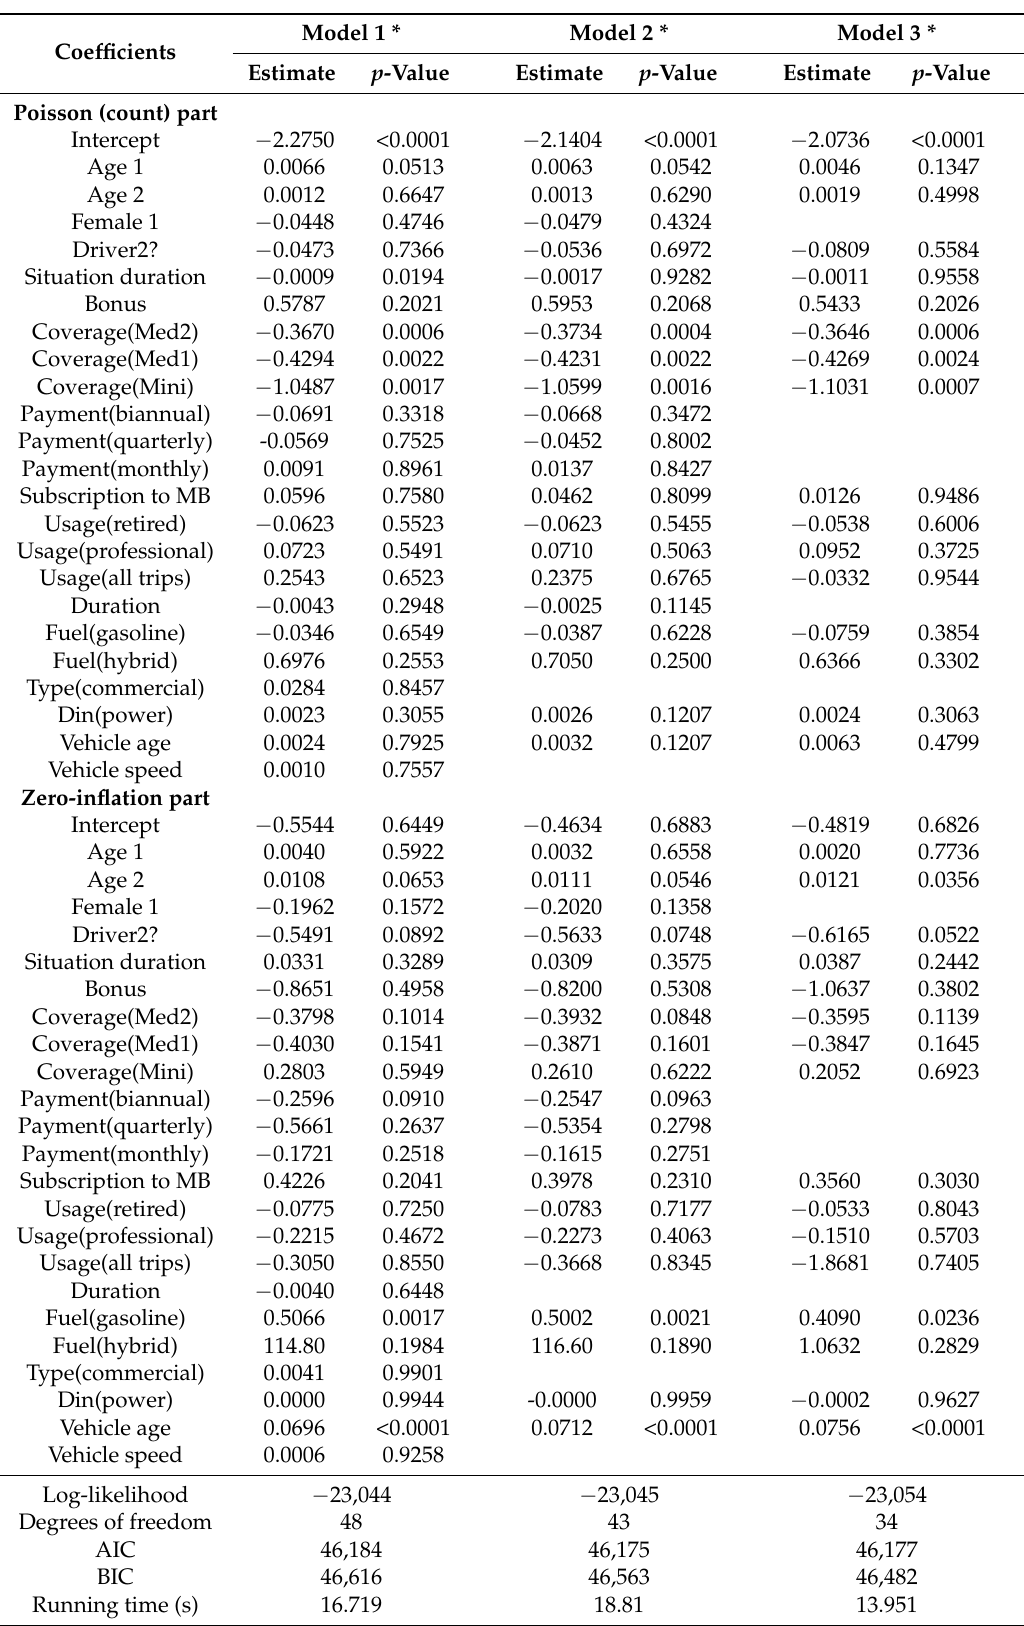
Table 6. Regression coefficients of zero-inflated Poisson (ZIP)